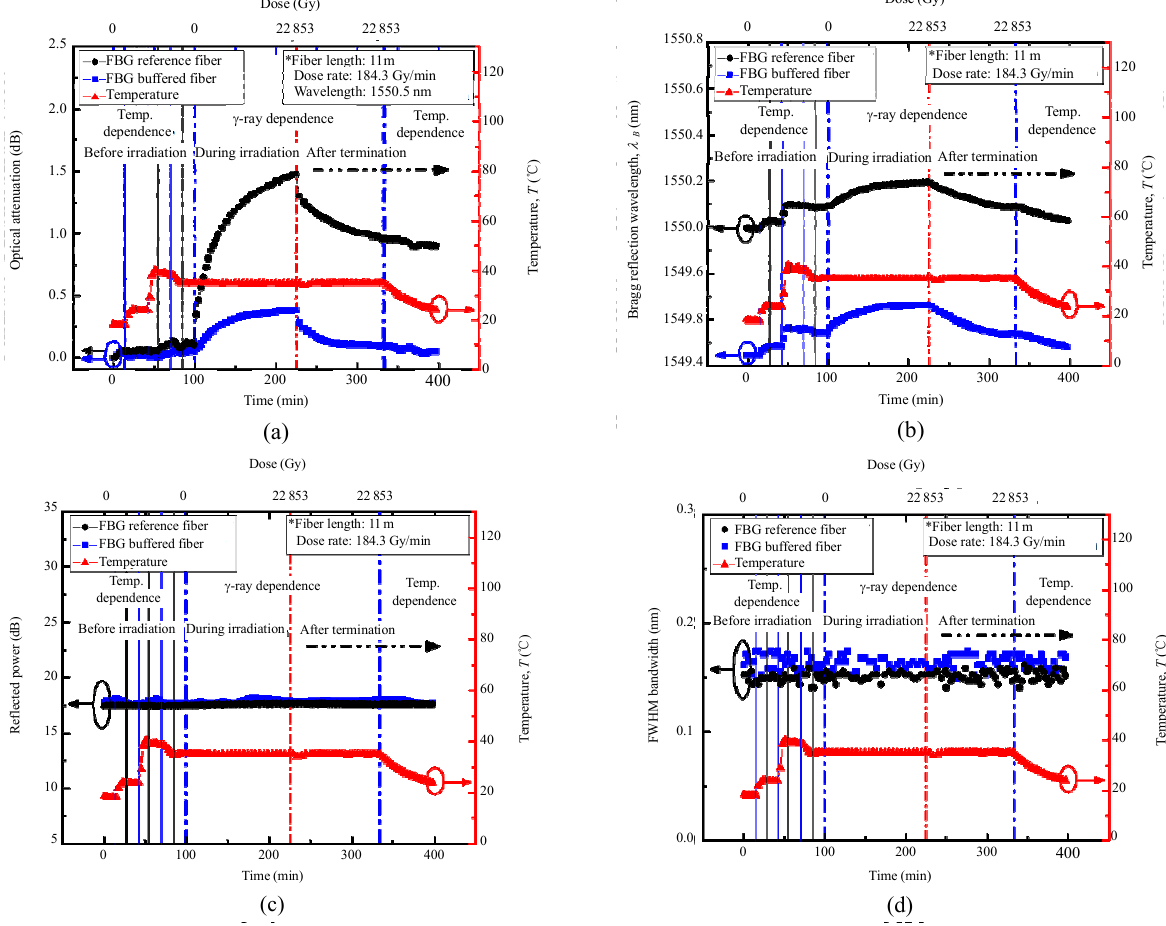
Fig. 7 Variations of (a) the optical attenuation, (b) the Bragg reflection wavelength, (c) the reflected power, and (d) FWHM bandwidth of the FBG fibers upon the change in temperature and the γ -ray irradiation